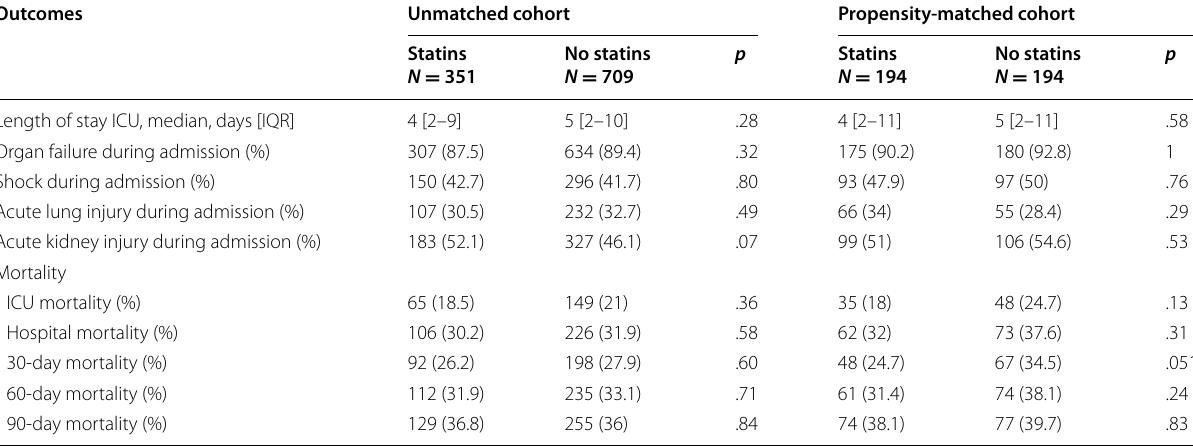
ICU intensive care unit, IQR interquartile range